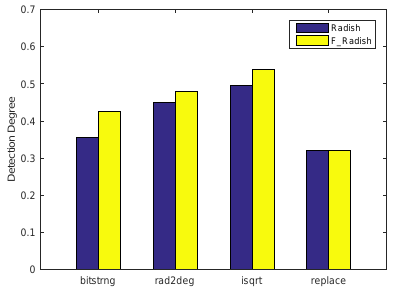
Figure 8. The detection degrees of F_Radish and Radish. (4) Different contributions of the two stages of